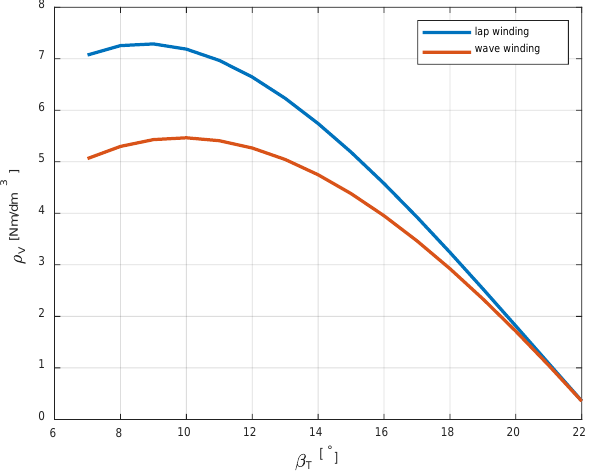
Figure 15. The torque-to-volume ratio as a function of the stator tooth width for lap and wave windings.